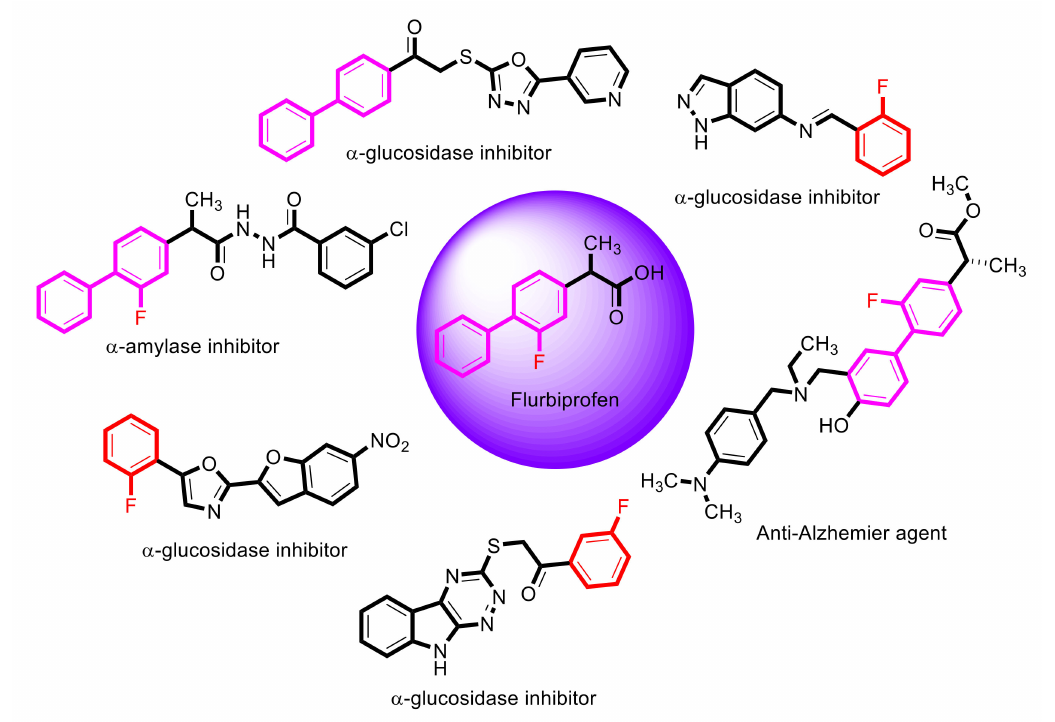
Figure 1. Reported α -glucosidase inhibitors